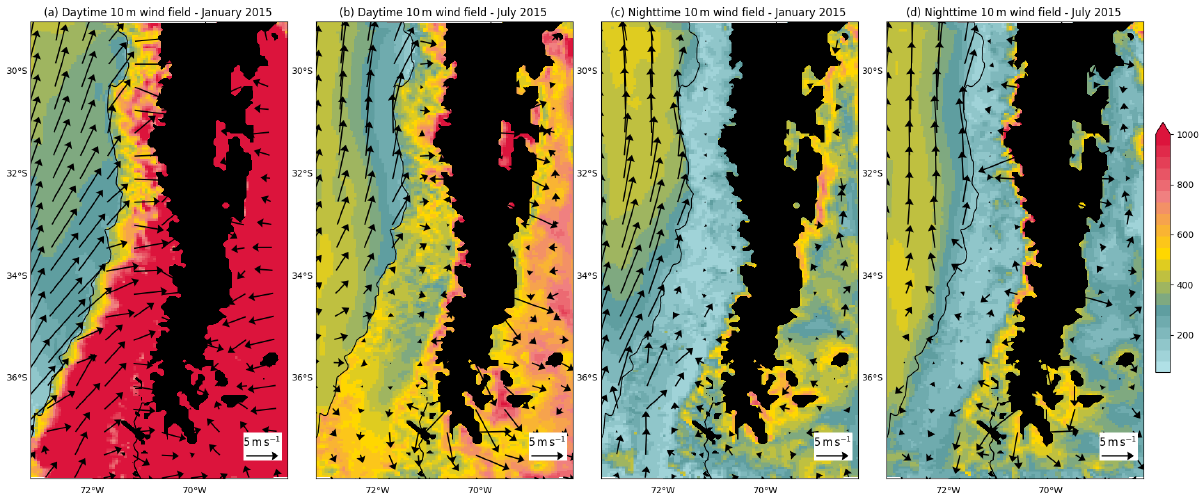
Figure 3. Average 10m wind field (arrows) and planetary boundary layer height (color map) simulated by WRF (a) during the daytime in January 2015 and (b) July 2015 and during nighttime in (c) January 2015 and (d) July 2015. Black areas show grid points with an elevation in excess of 2000ma . s . l